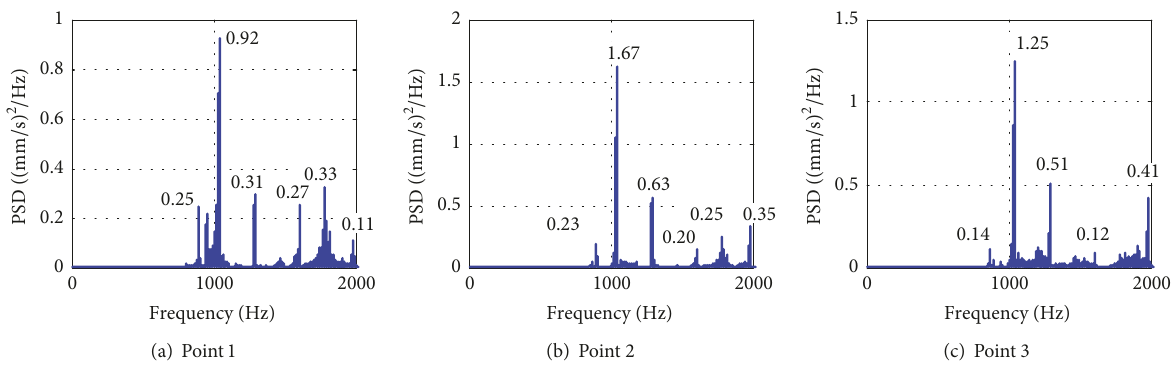
Figure 13: The measured PSD functions of cantilever cylindrical shell without hard coating at 3 measuring points.